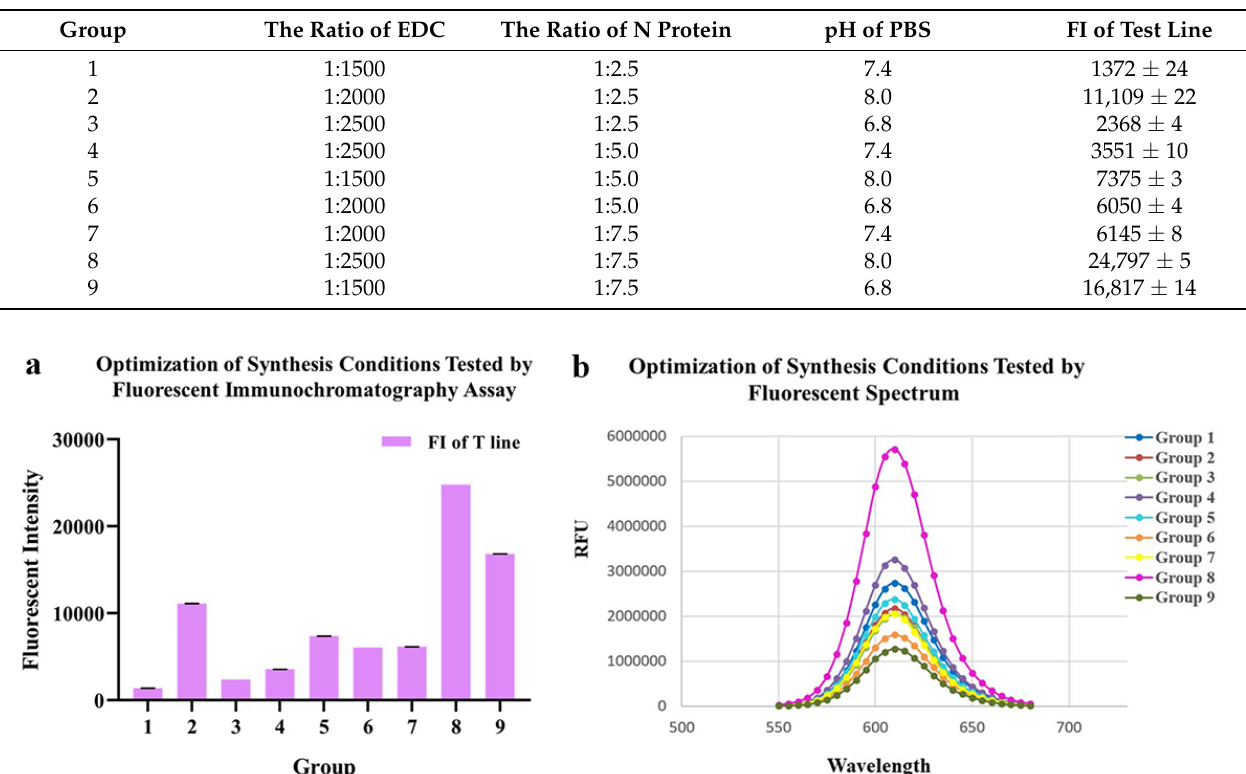
Table 1. Optimization of conjugating conditions of QDs-N probe by using orthogonal tests.